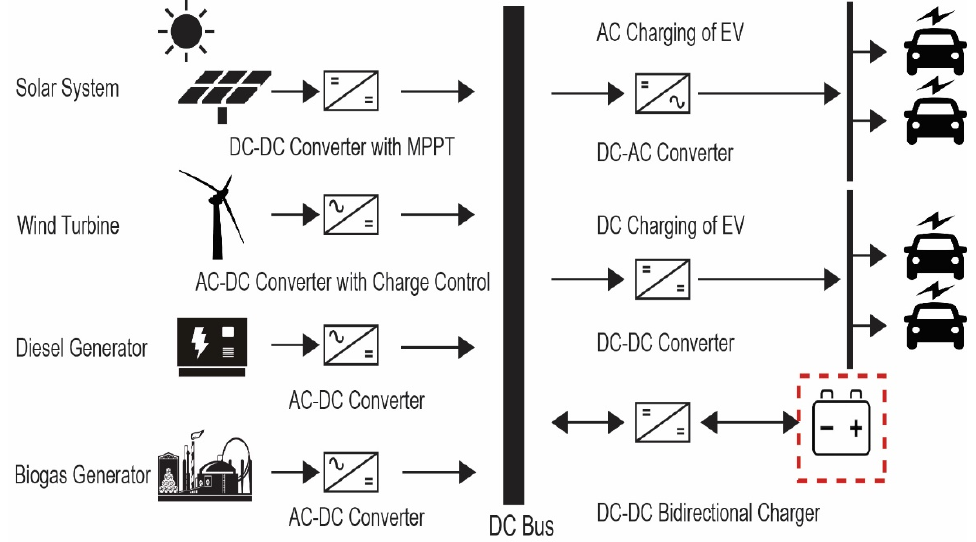
Figure 2. Standalone plugin electric vehicle charging station with single energy storage.